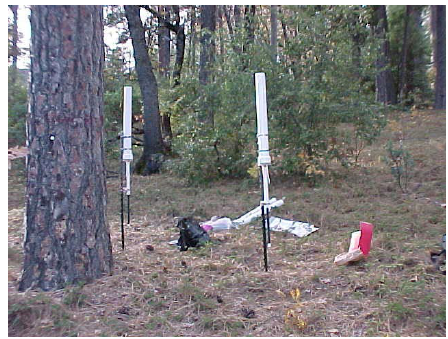
FIGURE 1 . Ion exchange resin column throughfall collectors installed in the field. The smaller dark-colored tube at the bottom is the resin column. The large white cylinders at the top are the snow collector tubes. In summer, the snow collector tube is removed and a similar white cylinder is placed over the resin column to reduce direct exposure to solar